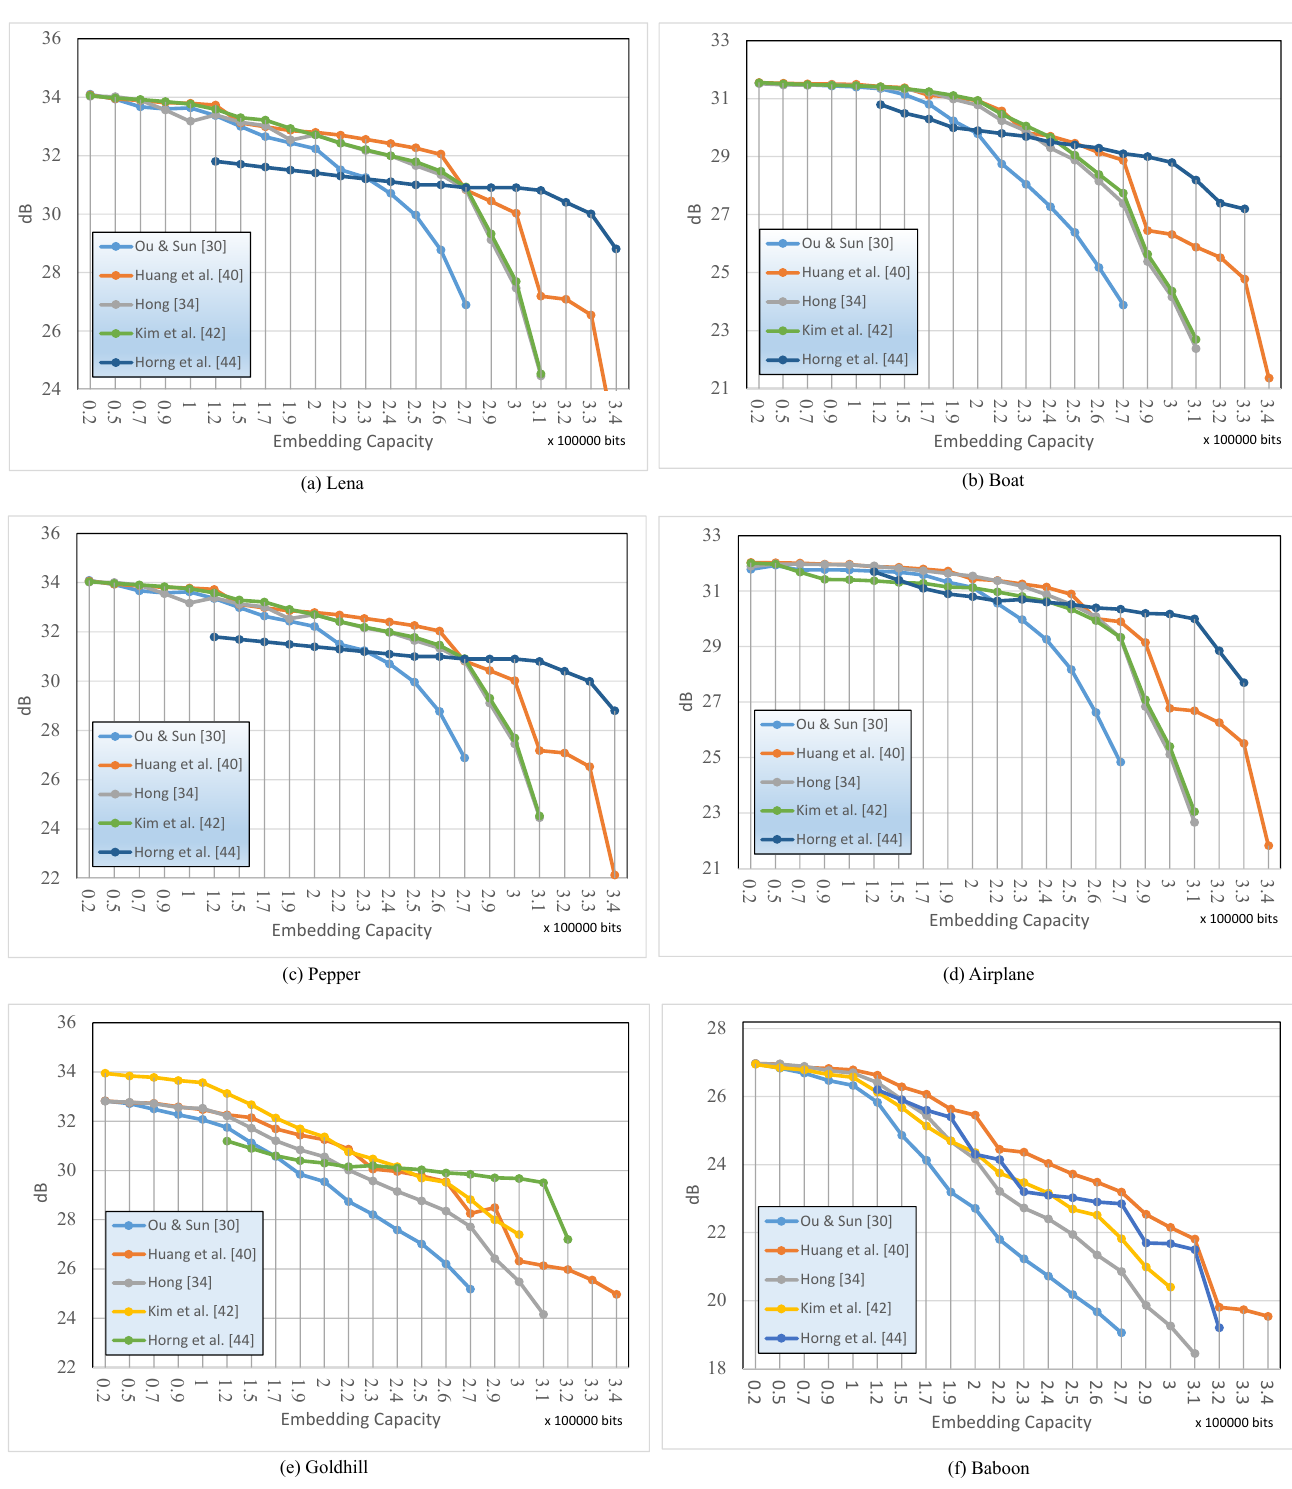
Figure 10. Comparison of the performance of PSNR vs.